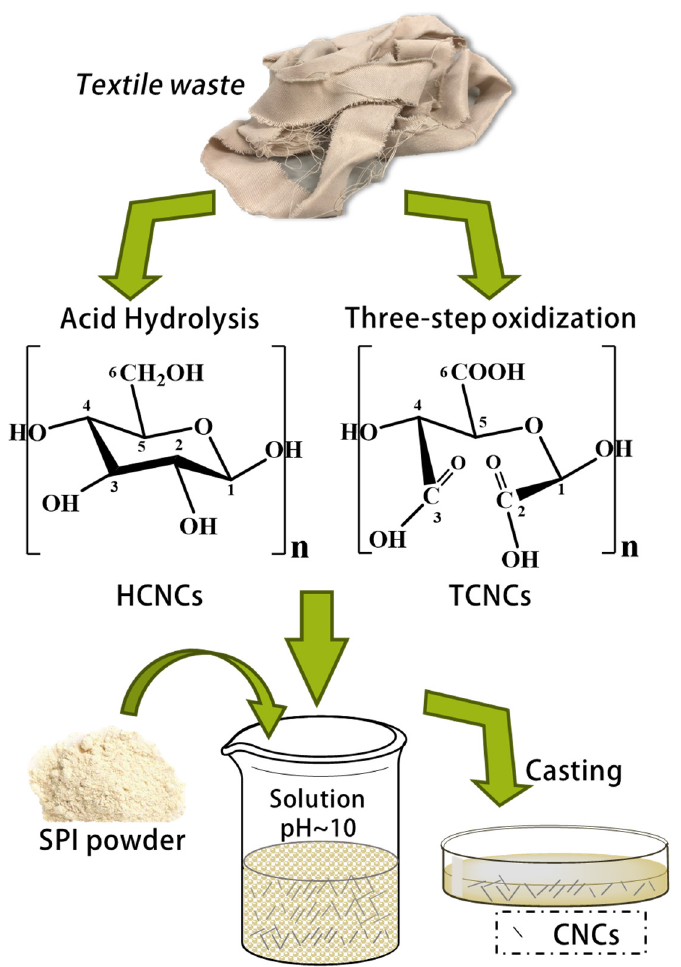
Figure 1. Schematic illustration of soy protein isolate (SPI) / cellulose nanocrystal (CNC) composite film preparation.